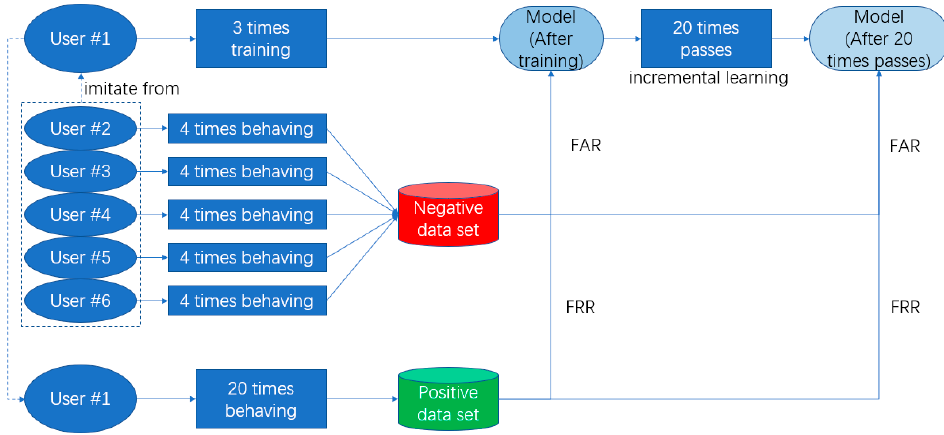
Figure 16. The three planes mapping of three gestures. ( a ) Is the simple gesture, ( b ) is the normal gesture, and ( c ) is the complex gesture.